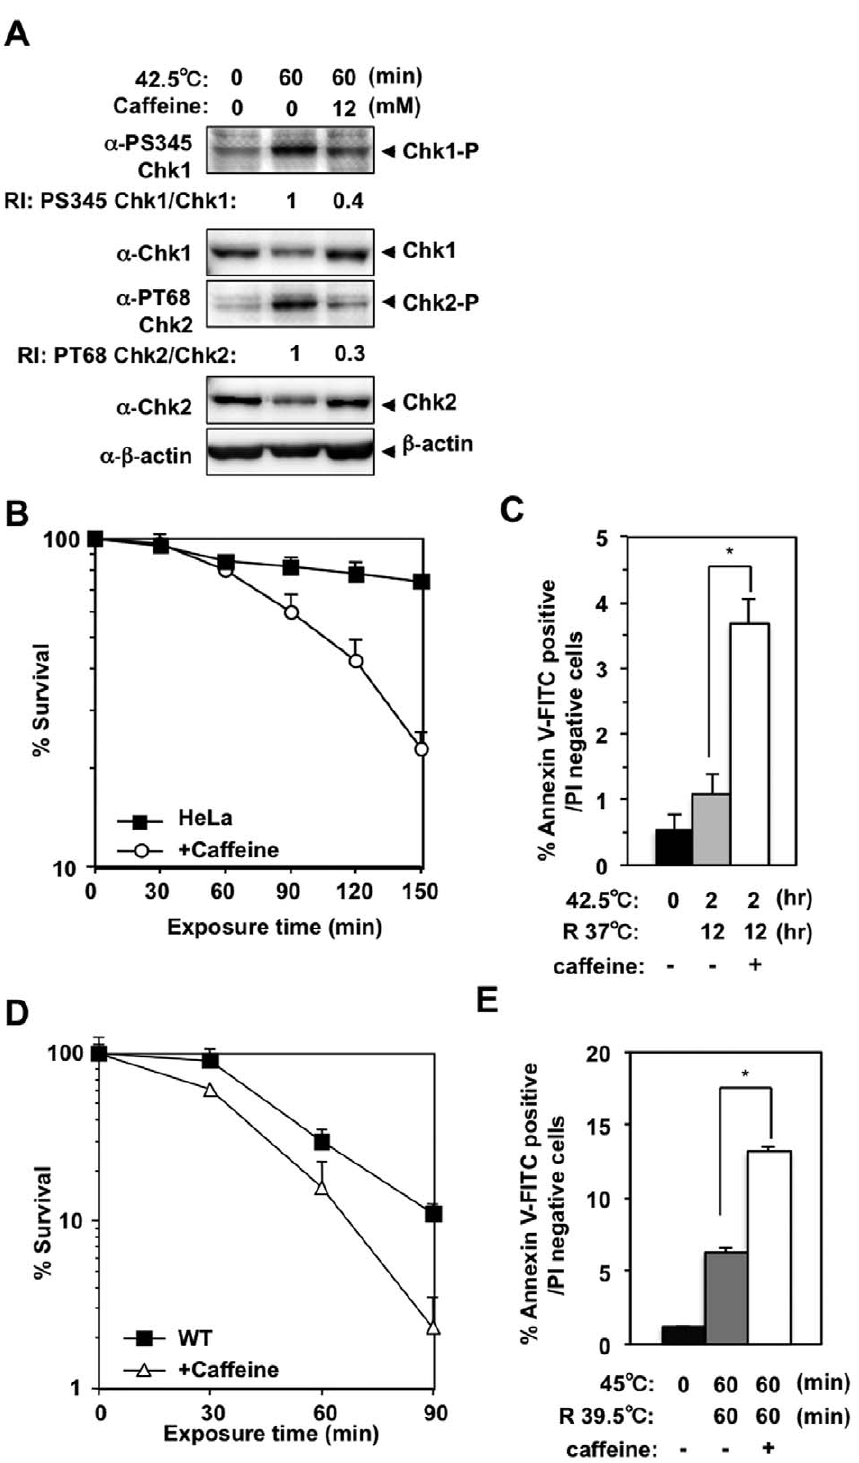
Figure 5. Caffeine suppressed heat-induced phosphorylation at Chk1 Ser345 and Chk2 Thr68 and enhanced heat cytotoxicity. A. Western blot. HeLa cells were cultured at 42.5 u C for 1 hour in the presence or absence of 12 mM caffeine. RI: relative intensity compared to the sample of 42.5 u C for 60 minutes. B. Clonogenic survival of heat-treated HeLa cells in the presence or absence of 12 mM caffeine. C. Apoptosis. HeLa cells were cultured at 42.5 u C for 2 hours and at 37 u C for 12 hours in the presence or absence of 12 mM caffeine. * p= 0.0019 (Student’s t test). D. Clonogenic survival of WT DT40 cells cultured at 45 u C for the indicated time in the presence or absence of 2 mM caffeine. E. Apoptosis. WT DT40 cells were cultured at 45 u C for 60 minutes and at 39.5 u C for 60 minutes in the presence or absence of 2 mM caffeine. * p= 0.0014 (Student’s t test).